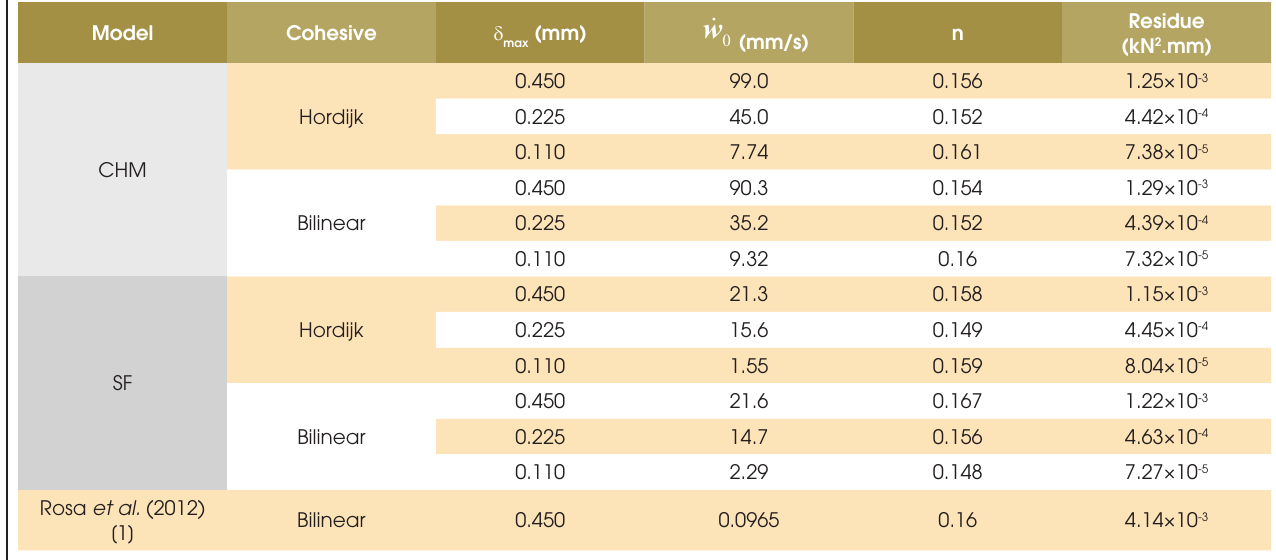
Table 5 – Results obtained by inverse analysis of the viscous model [1] using the cohesive curves numerically determined in Section 5.3